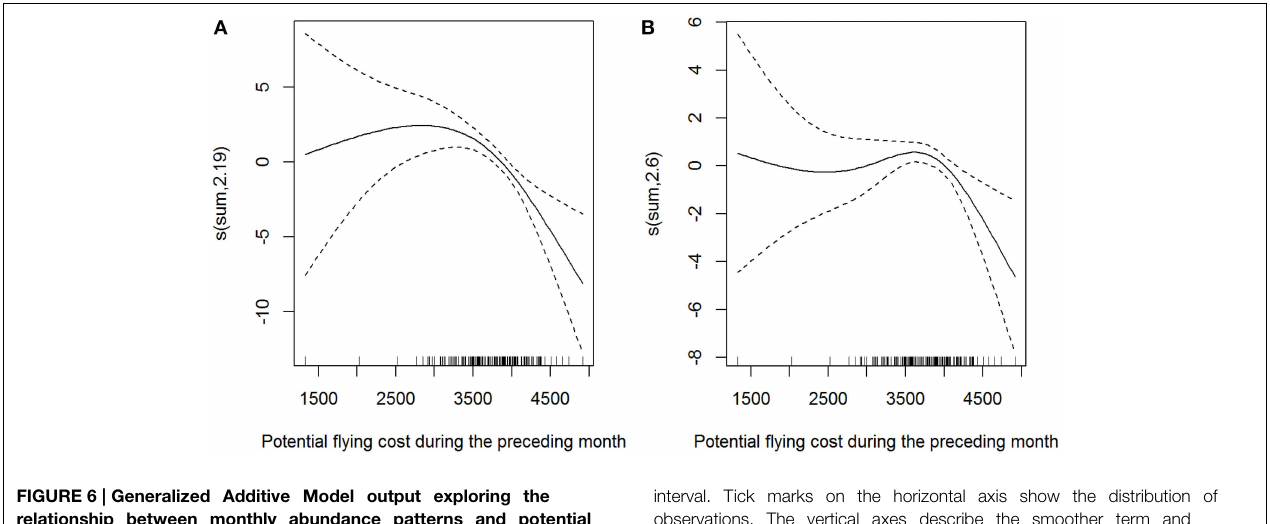
FIGURE 6 | Generalized Additive Model output exploring the relationship between monthly abundance patterns and potential flying costs of the preceding month for (A) great and (B) sooty shearwaters, respectively, from January 1996 to December 2009. Dotted areas represent the 95% confidence